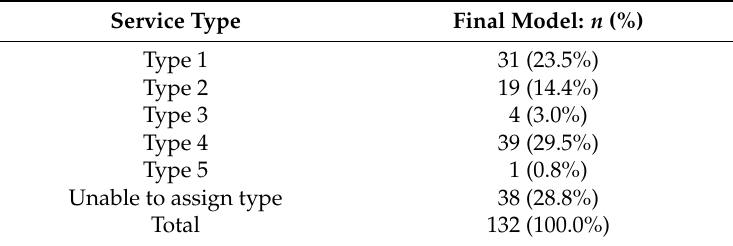
Table 6. Performance of STAX-SA.